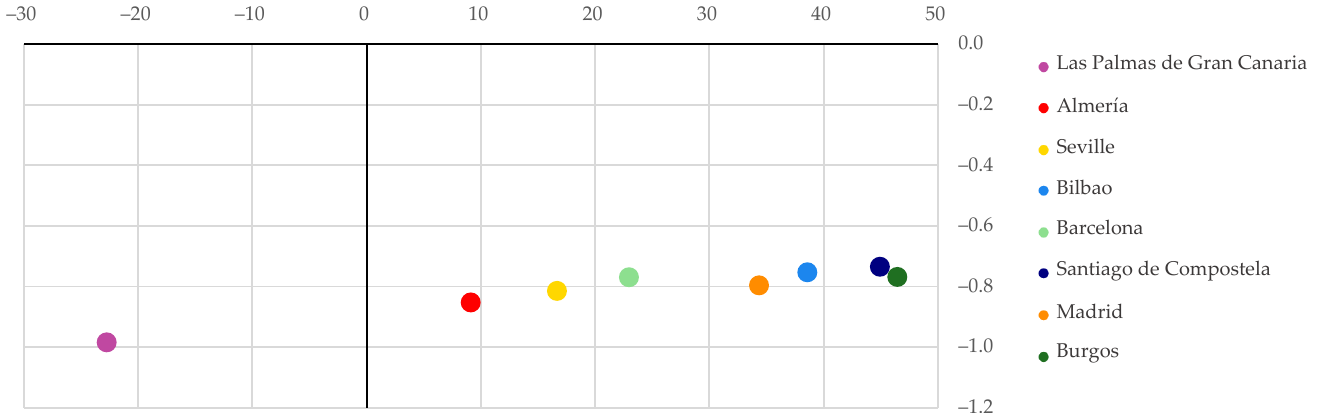
Figure 8. Total energy savings (%) of model B in relation to the reference model regarding the aver- age annual temperature (°C) in each of the 8 cities. This behaviour can be justified based on different concepts. In the first place, as they are self-sustaining green roofs, the water available for losses due to evapotranspiration is limited. Therefore, in areas with higher temperatures and solar radiation, greater heat losses are produced by evapotranspiration but are limited to the amount of water availa- ble, since these cities coincide with lower annual rainfall. These green roofs do not develop their maximum cooling potential by evapotranspiration. On the other hand, regarding the geometry of the building, it is observed that the main orientations are south and west. These facades are the ones that receive the greatest amount of solar radiation and are also the ones with the highest proportion of openings (greater than 20%), while the north facade does not reach a proportion of 6% and the east party wall is adiabatic, in contact with the attached house. The proposed study only con- templates an improvement of the thermal envelope of the building, without the introduc- tion of other elements of solar control. These elements could avoid the direct incidence of the sun and reduce the transmission of heat through the most exposed windows and fa- cades. Therefore, the south and west facades, together with their windows, reach high outside temperatures throughout the day due to incident solar radiation. The increase in thermal insulation and inertia of the facades, at the same time as the solar control treat- ments of the window pane, reduce and delay the transmission of heat from the outside to the interior of the house. However, part of the heat will arrive, delayed in time, inside the